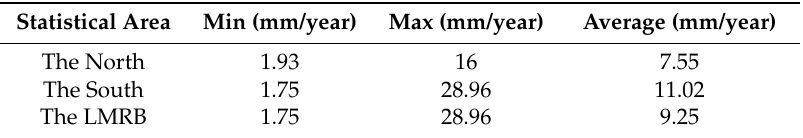
Figure 3. Interpolated subsidence-rate map in the Lower Mississippi River Basin. Table 1. Statistics of interpolated subsidence rates.